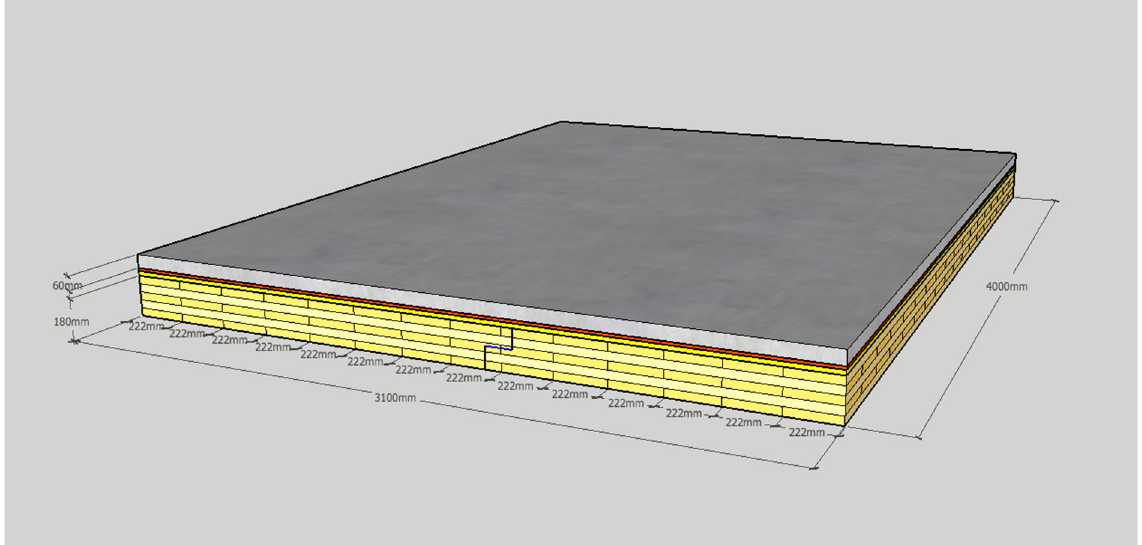
Figure A4. Perspective sketch of the structure of floor 9, which includes the following: 180 mm CLT (split in two pieces rigidly connected with metal screws of 150 mm in length), 20 mm glass wool, 13 mm vibration isolation (vibration mat B), 1 mm plastic foil (waterproof), and 60 mm concrete screed (from bottom to top).